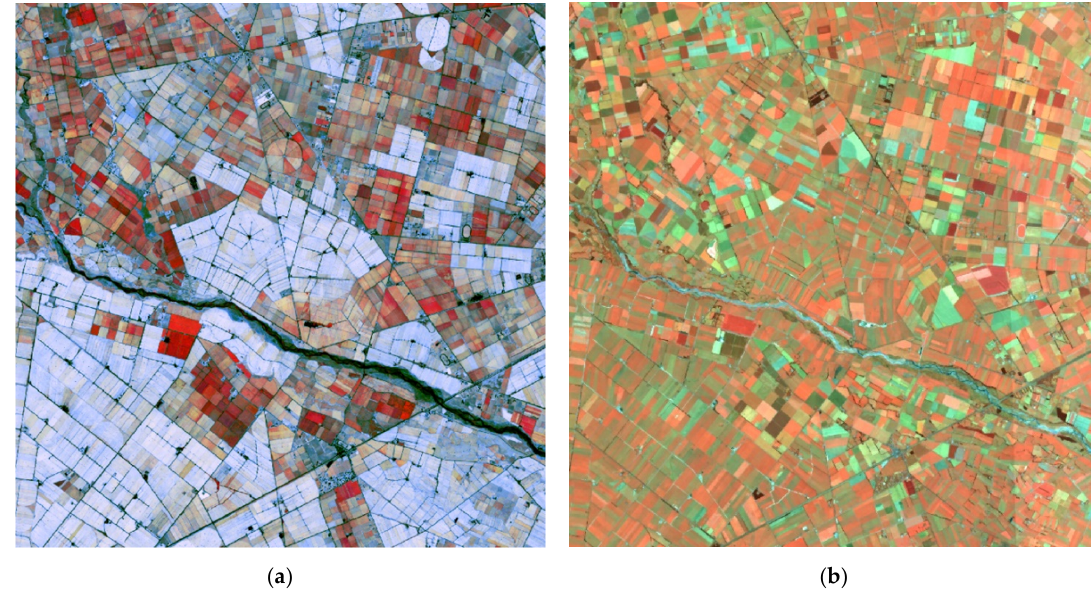
Figure 13. ( a ) A map of Canterbury highlighting vegetation patterns indicative of rotational cropping (red) and permanent pasture (blue) using ratios of positive NDVI images on the left; and ( b ) a topographically flattened summer mosaic of the same area.